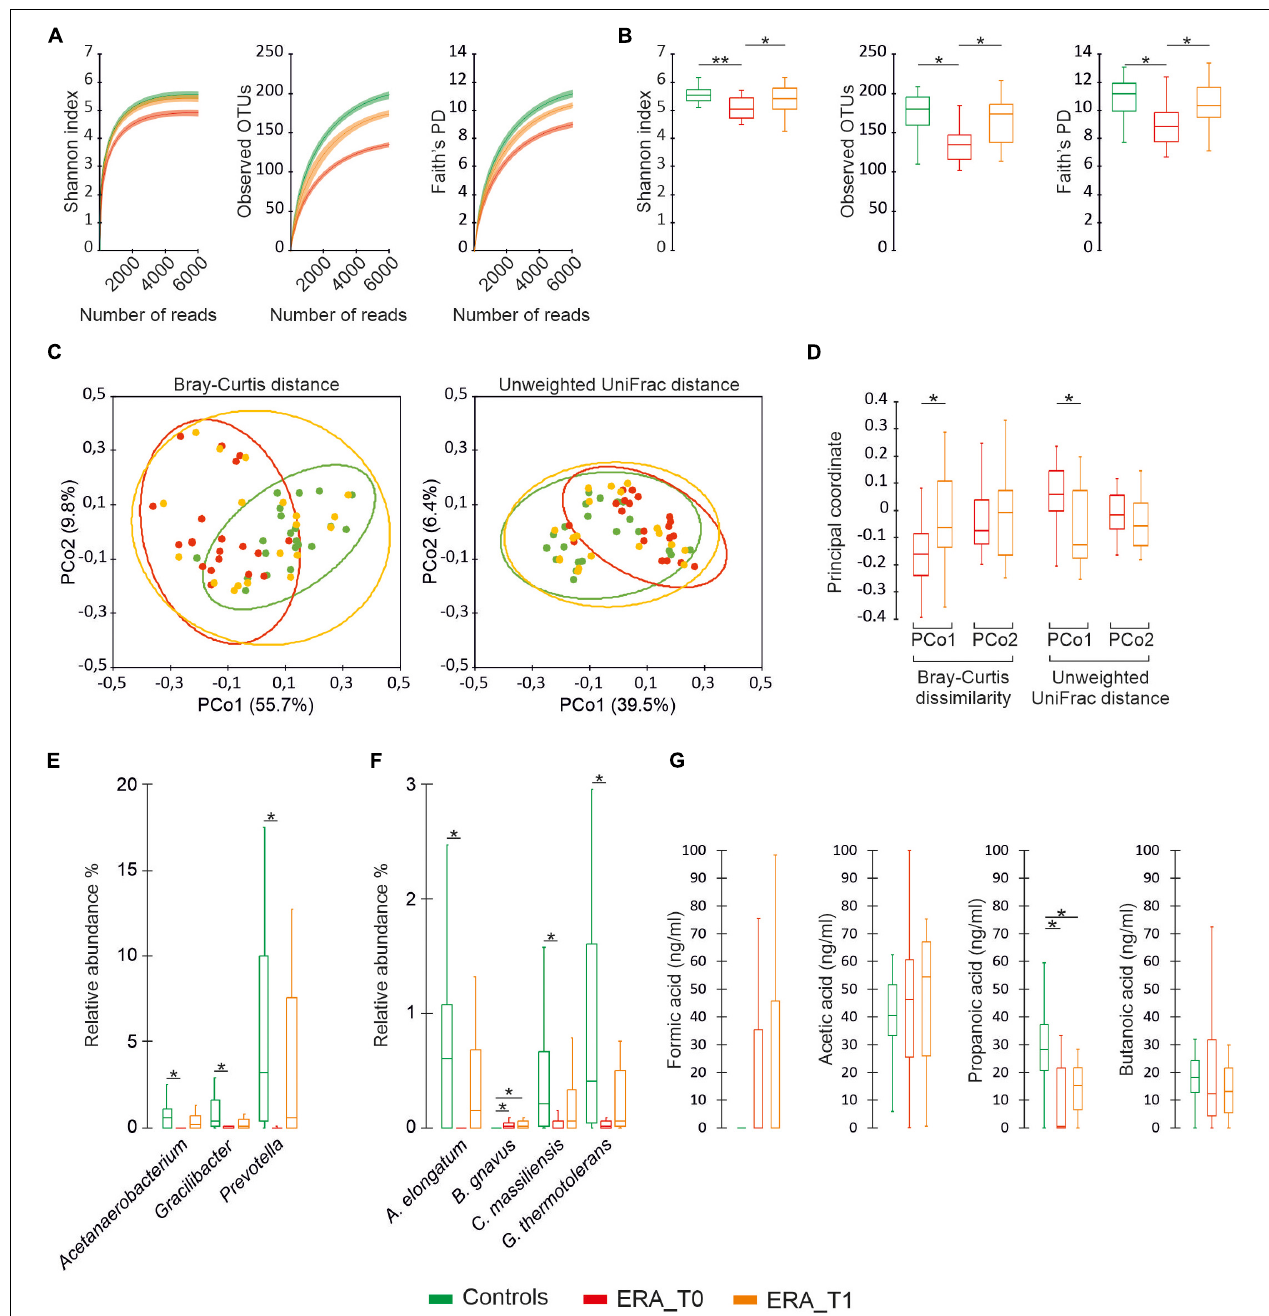
FIGURE 2 | Microbiota diversity analysis. (A) Color coded rarefaction curves. For each group, the average values of α -diversity indexes with 95% confidence intervals were reported at different sequencing depth. (B) Color-coded box and whisker plots showing the distribution of the considered α -diversity estimators among groups. The presence of statistically significant difference between group of data were also reported. (C) PCoA plot of bacterial α -diversity based on Bray-Curtis dissimilarity and Unweighted UniFrac distance according to considered groups of subjects. For each group, the 95% confidence interval has been drawn. Numbers between parentheses represents the percentage of the total variance explained by the principal coordinates. (D) Color-coded box and whisker plots showing the distribution of principal coordinates for the ERA group between different time points. (E,F) Differential abundance analysis of taxa at genus and species levels with a mean relative abundance ≥ 1% determined in at least one group. (G) Distribution of SCFAs levels among groups. The Mann-Whitney U test and was performed to determine statistically significant differences between the control group and the RA one at both considered time-points. The Wilcoxon Signed-Ranks test was performed to assess significant differences between the different time-point considered for the ERA group. The * and ** difference is statistically significant.